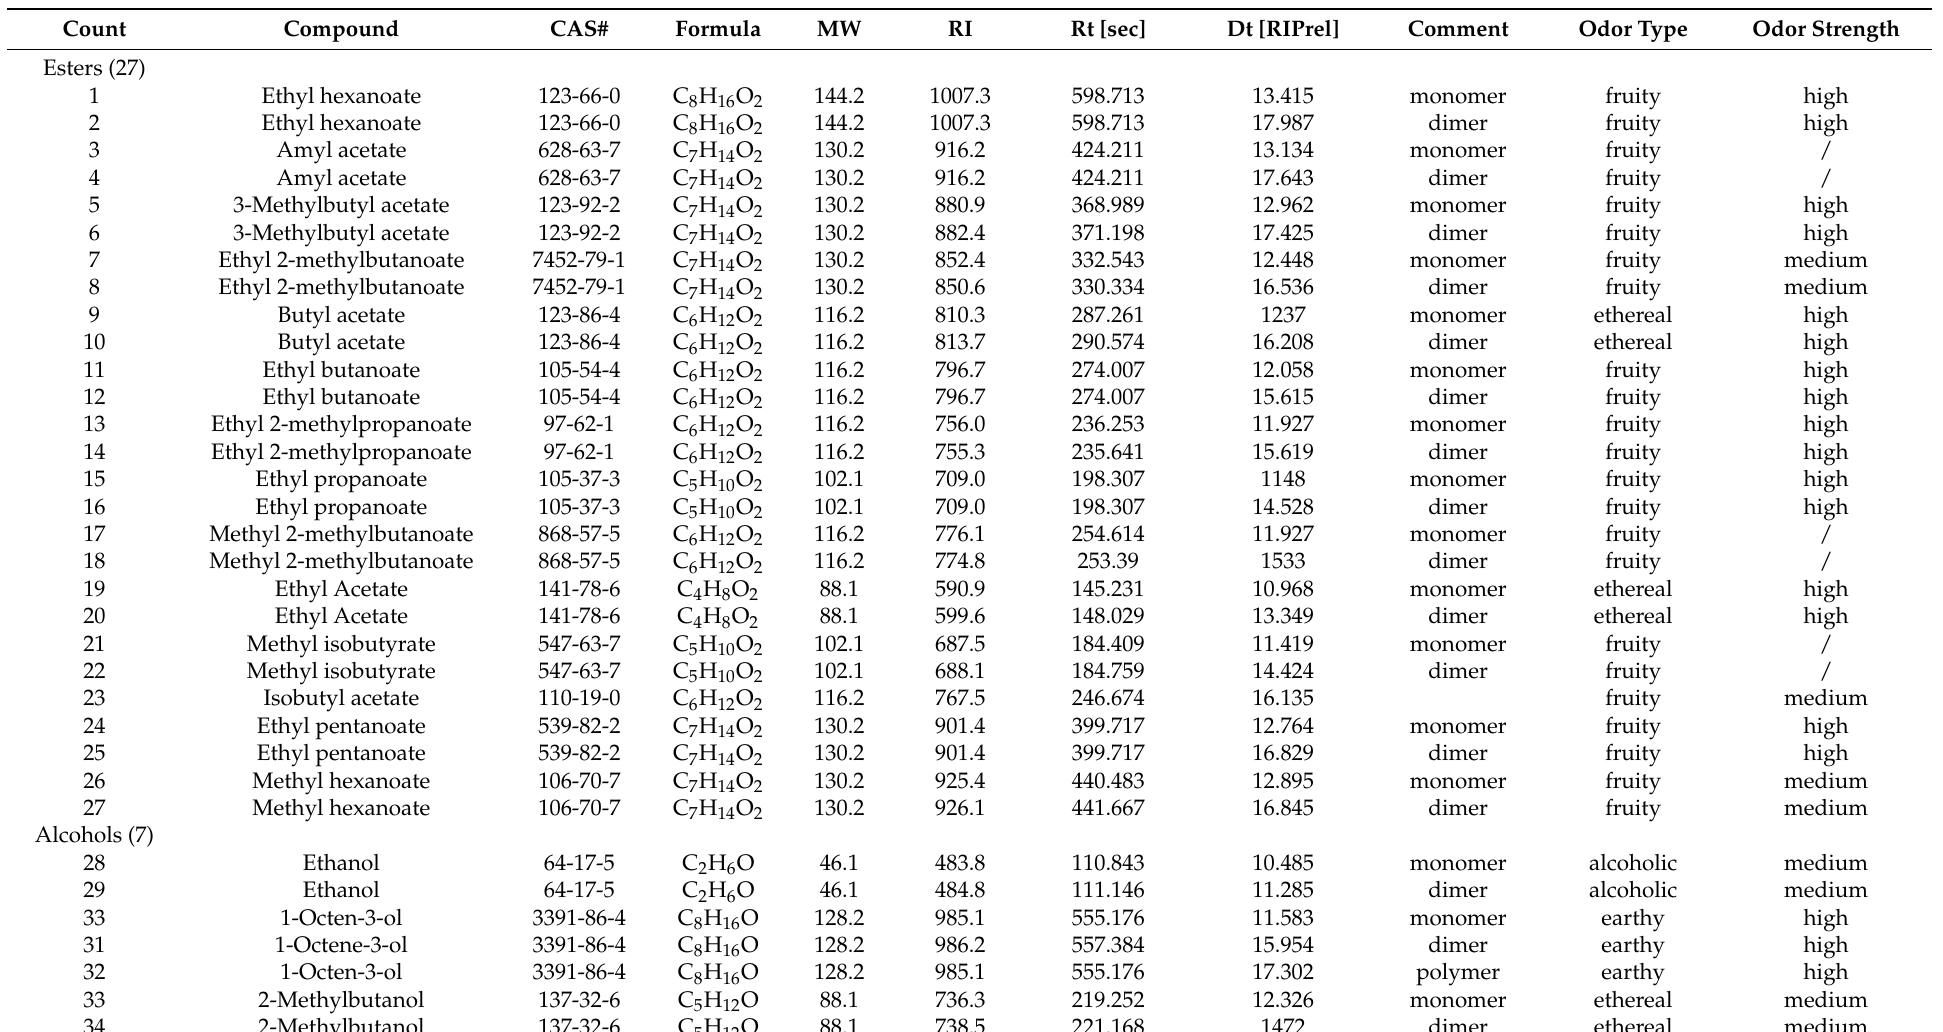
Table 1. Volatile flavor compounds in oriental melon identified by